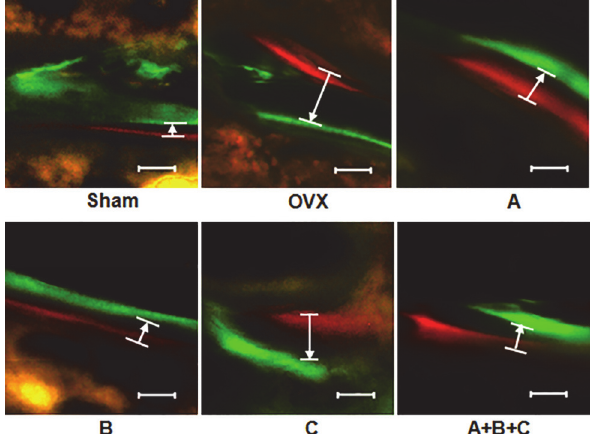
Fig 1. Representative fluorescent micrographs of the trabecular bone sections show the apposition of the xylenol (red) and calcein (green) labels in the sham-operated (Sham), ovariectomized only (vehicle- treated) (OVX), and OVX mice treated with different XLGB fractions. The white arrow pointed to the labeled the distance between two sequential fluorescent dyes in a time interval of 8 days. 20 x, bar = 10um.